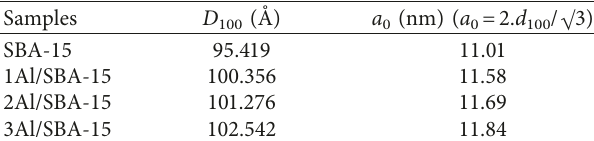
Figure 1: Small angle (a) and wide angle (b) XRD patterns of SBA-15 and xAl/SBA-15. Table 1: Characterization of the crystal structure of all